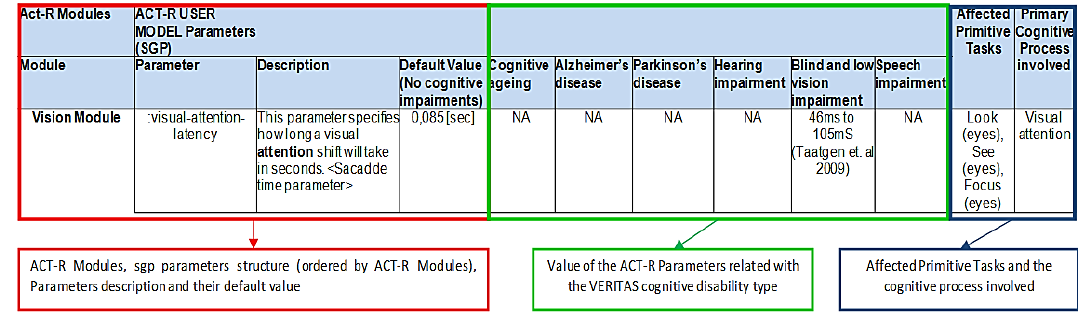
Figure 4. Structure of the ACT-R (sgp) User Model parameters. Note: Taatgen et al. [43].